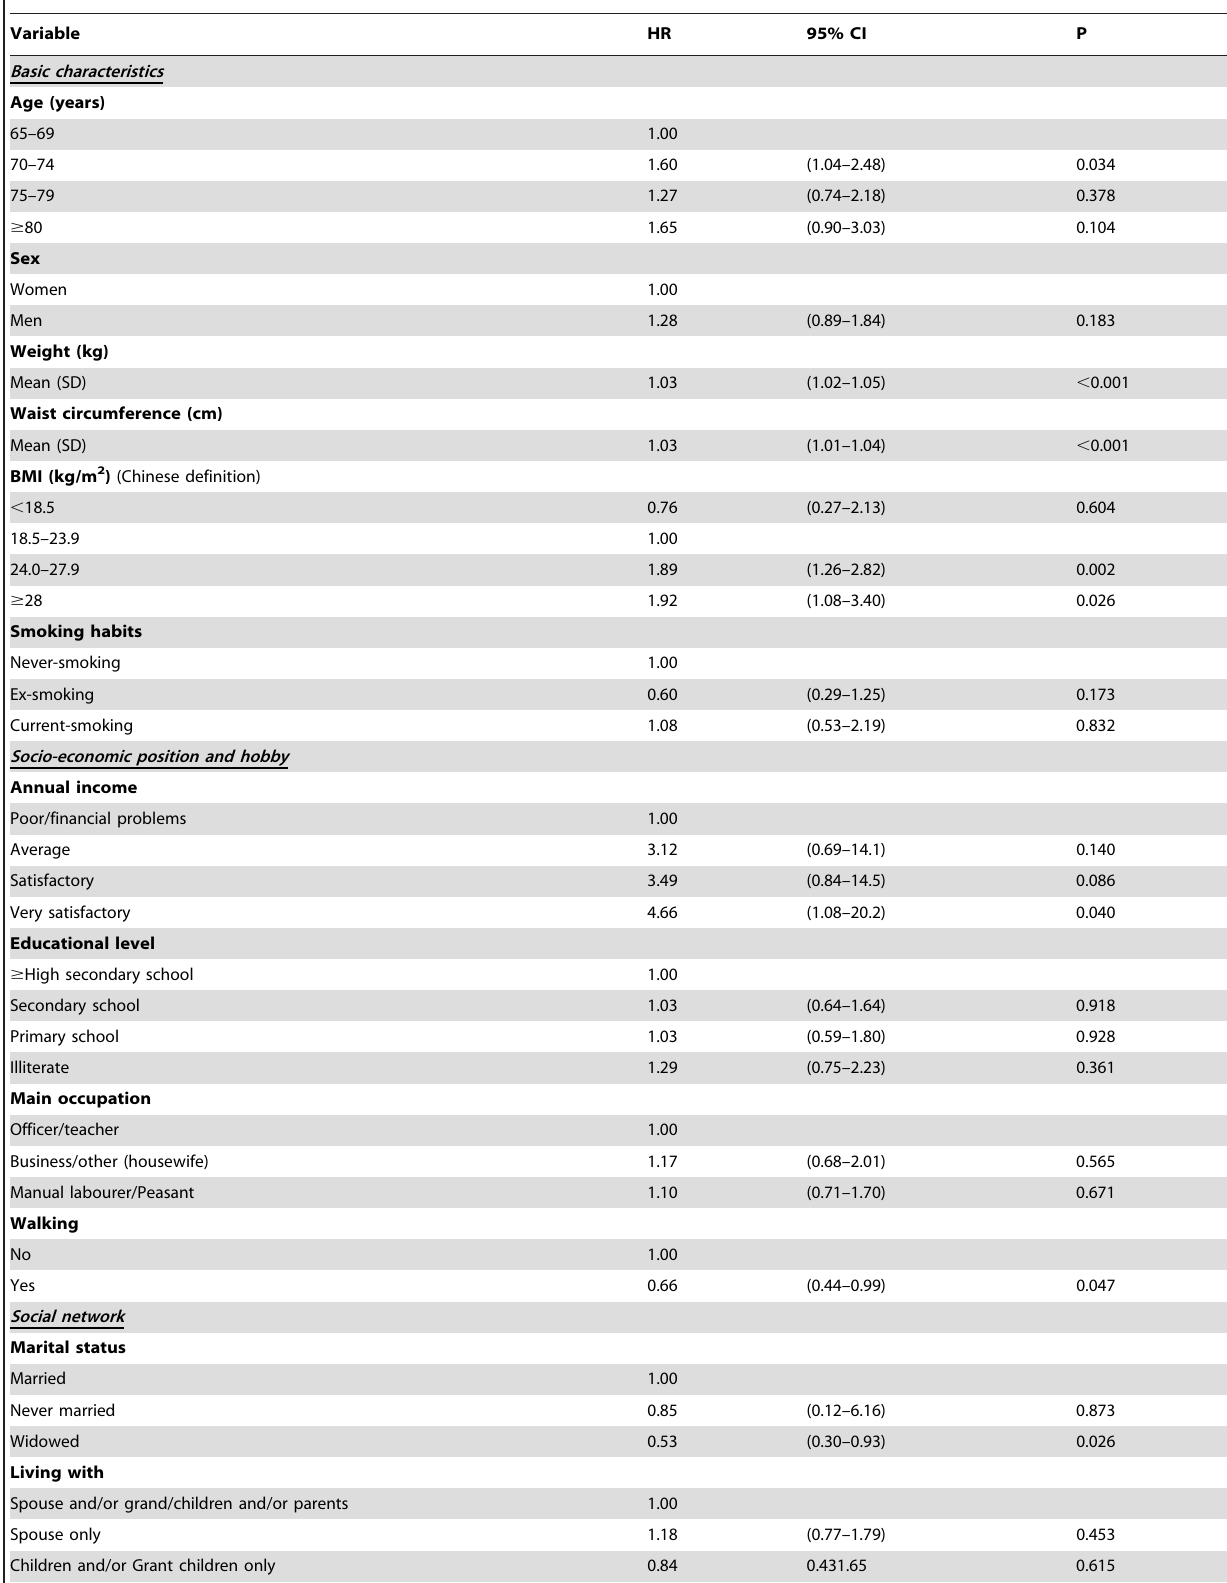
Table 2. Age-and sex-adjusted hazard ratios for incident diabetes in older people – Hefei cohort study, China.